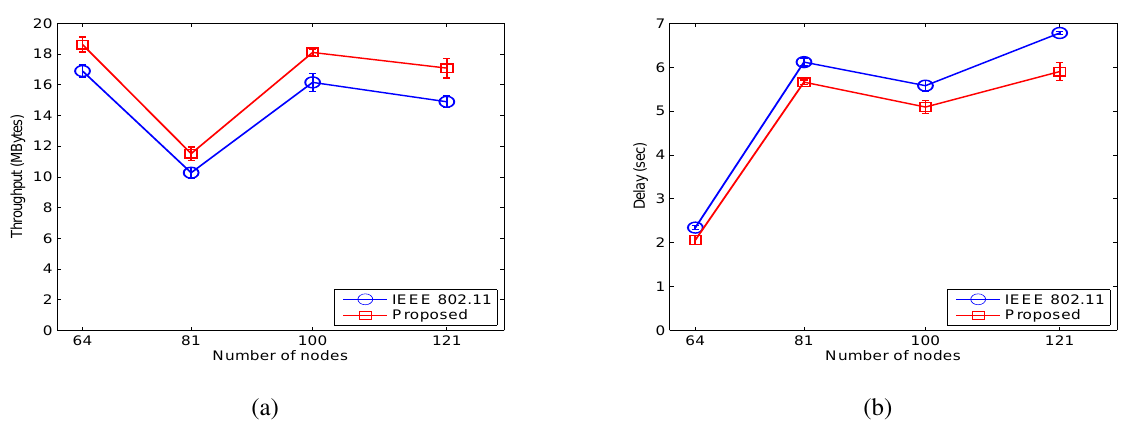
Figure 11. Simulation results for random networks when σ (b) Delay.